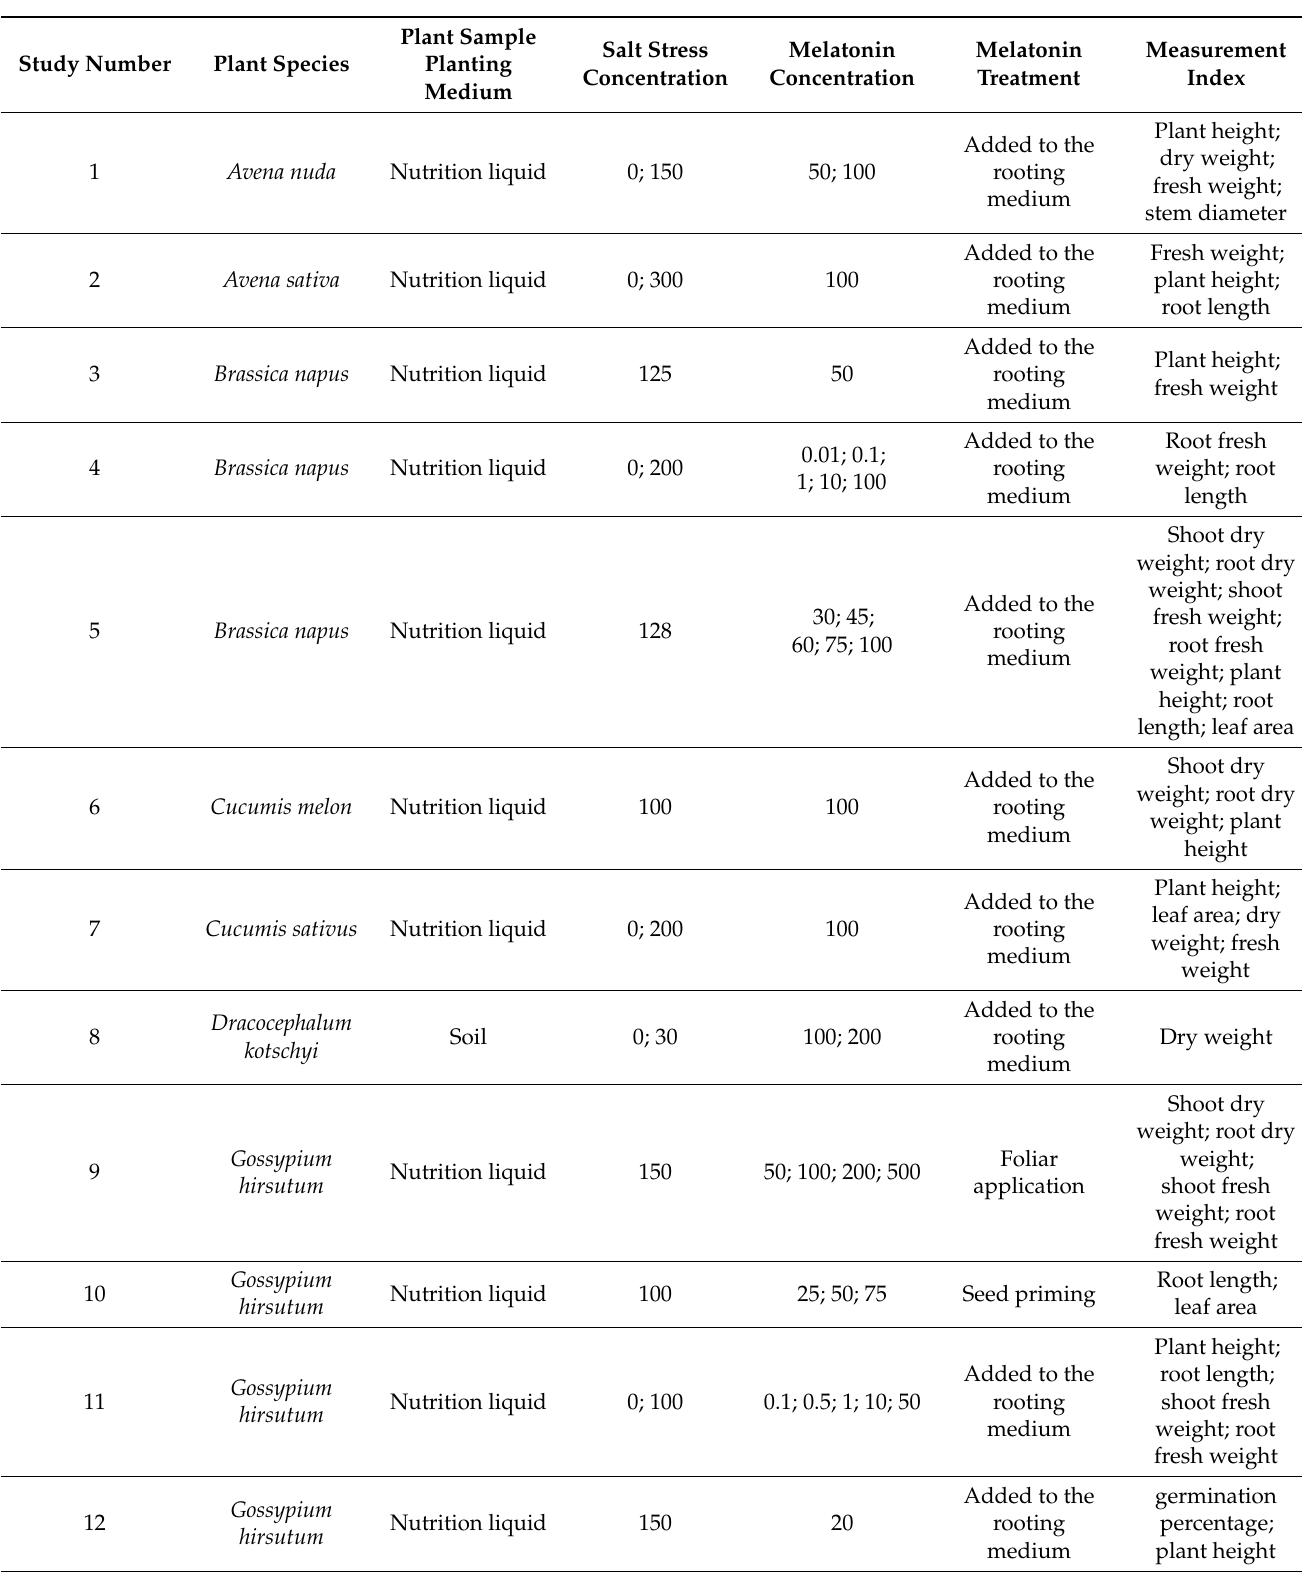
Table A1. Overview of the studies used for this